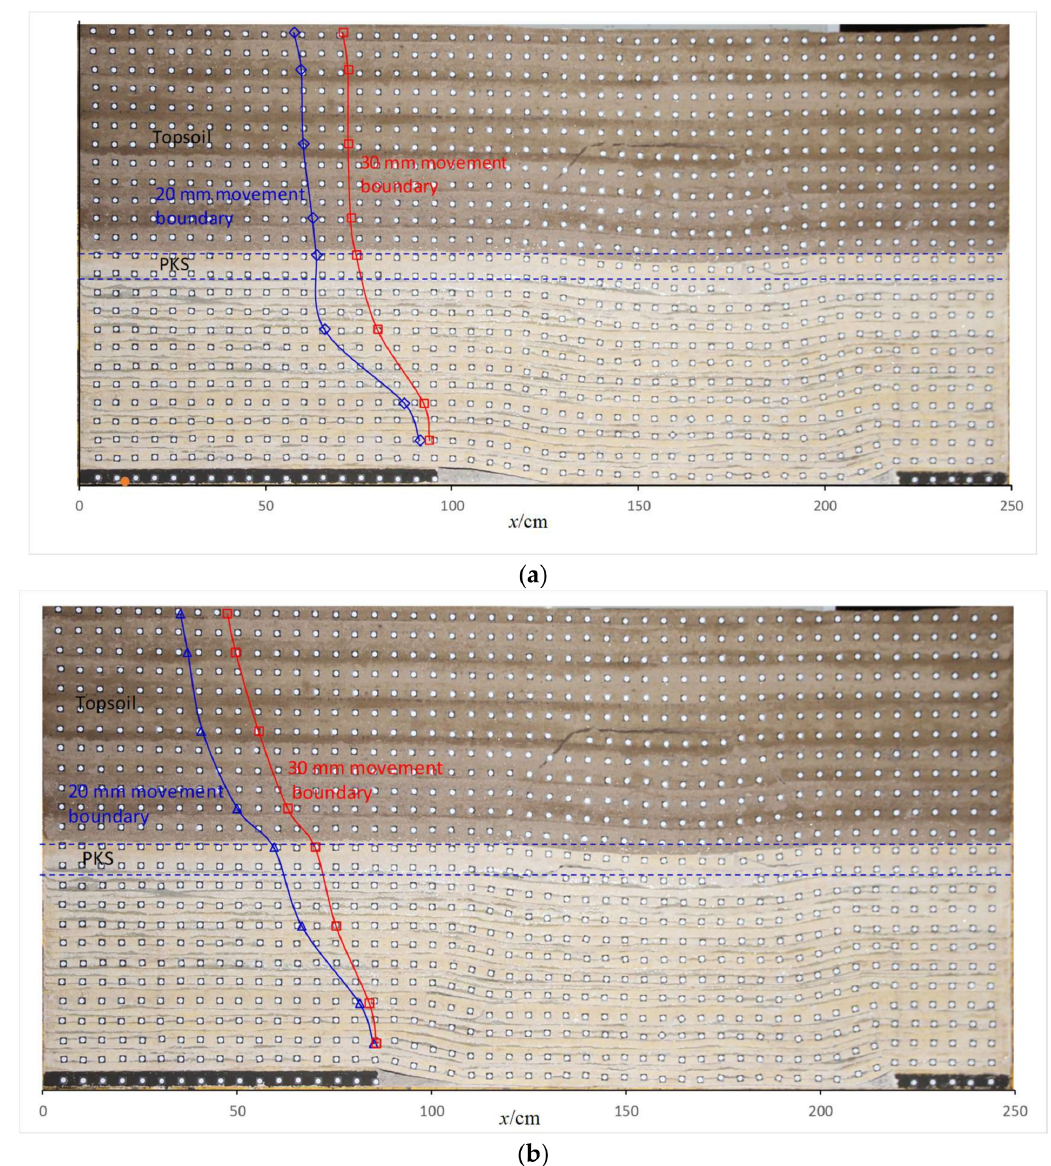
Figure 9. Strata movement boundary in physical simulation. ( a ) Strata movement boundary when working face proceeds to 125 cm; ( b ) Strata movement boundary when working face proceeds to 135